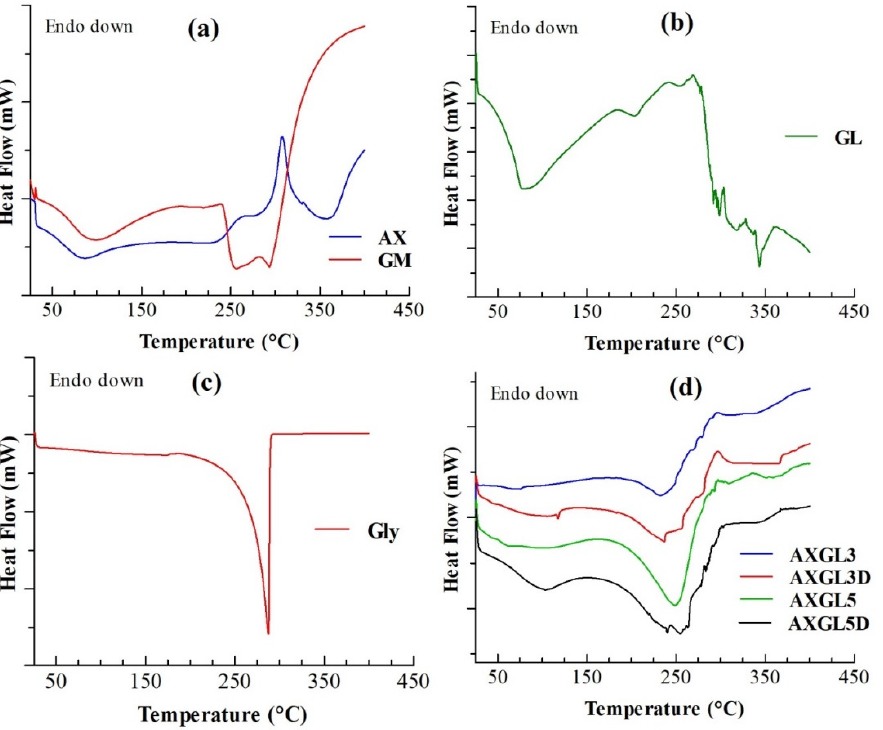
Figure 3. Differential scanning calorimetry (DSC) analyses of ( a ) arabinoxylan (AX) and gentamicin (GM), ( b ) gelatin (GL), and ( c ) glycerol, and (d) AX-GL films.